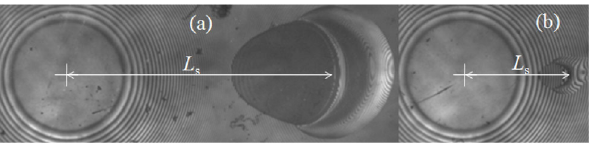
Fig. 6 Initial spreading positions of large and small droplets, (a) D ini = 452 μ m; (b) D ini = 142 μ m, PAO100, w = 48 N.